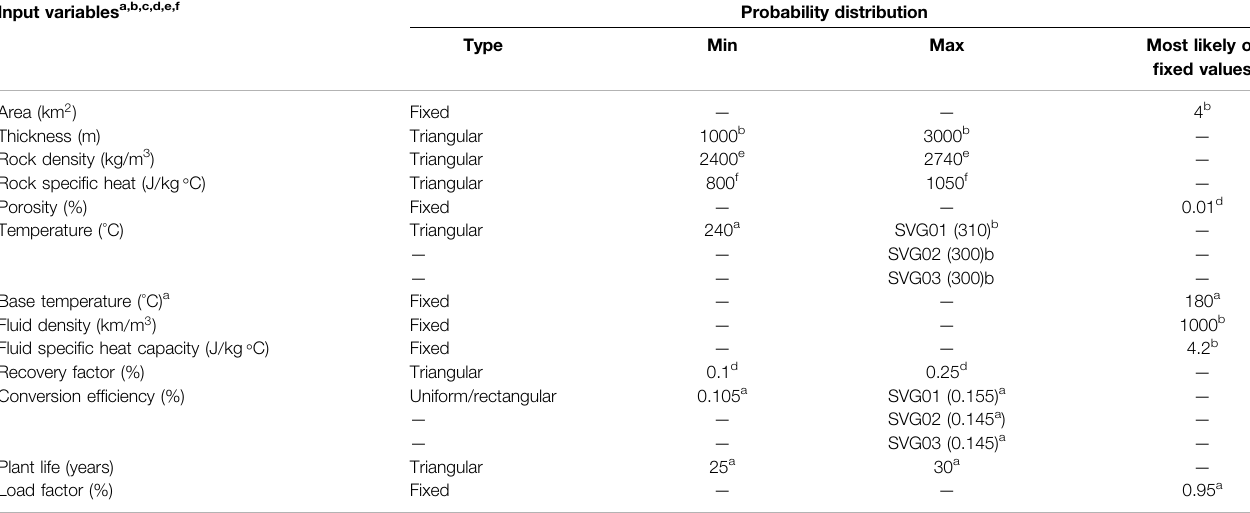
TABLE 3 | Best estimates of input parameters for all three wells (SVG01, SVG02, SVG03) for the volumetric assumption utilized for the Excel-based Monte Carlo simulation. Input variables